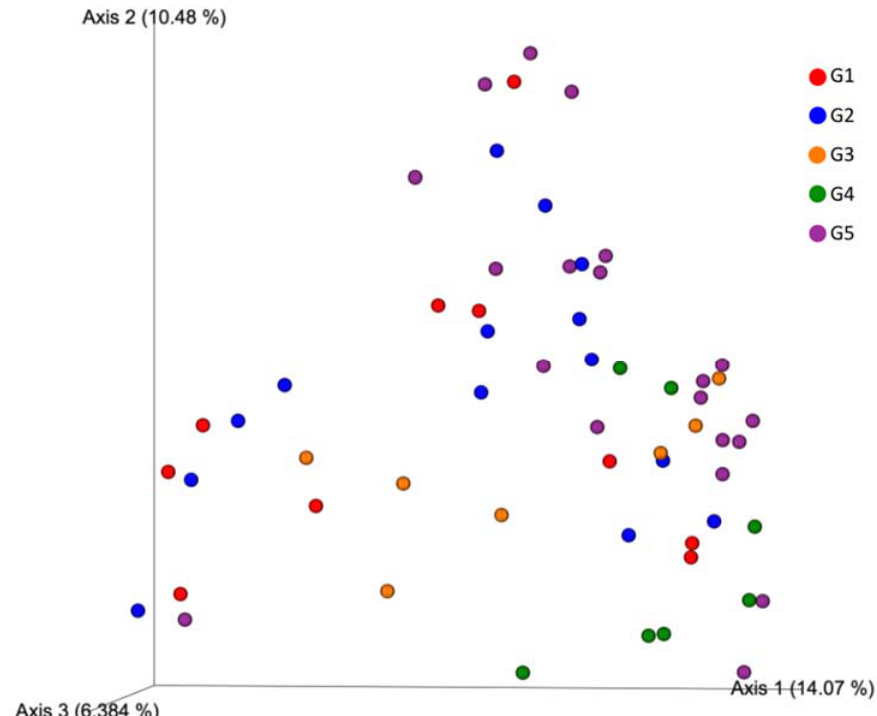
Figure 6. Principal coordinates analysis (PCoA) plot based on unweighted (qualitative) phylogenetic UniFrac distance matrices of water samples according to geographic proximity .